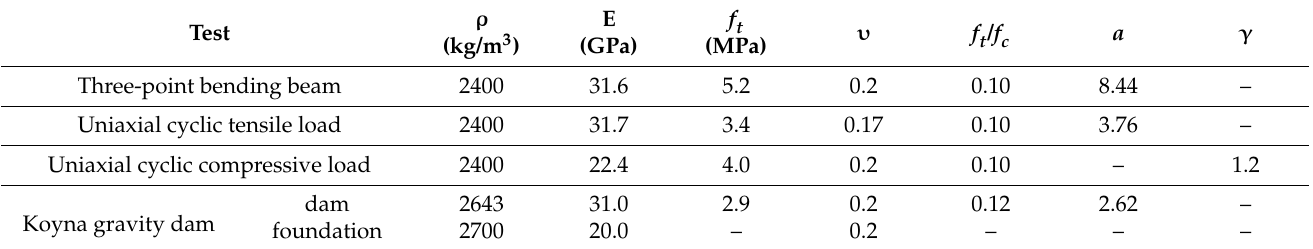
Table 1. Material parameters of